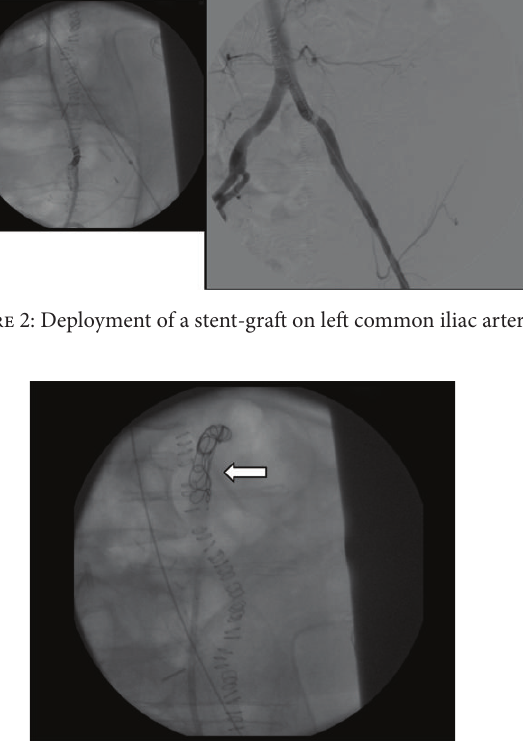
Figure 3: Occlusion of ureteral stump by mean of metallic coils (arrow), followed by Onyx